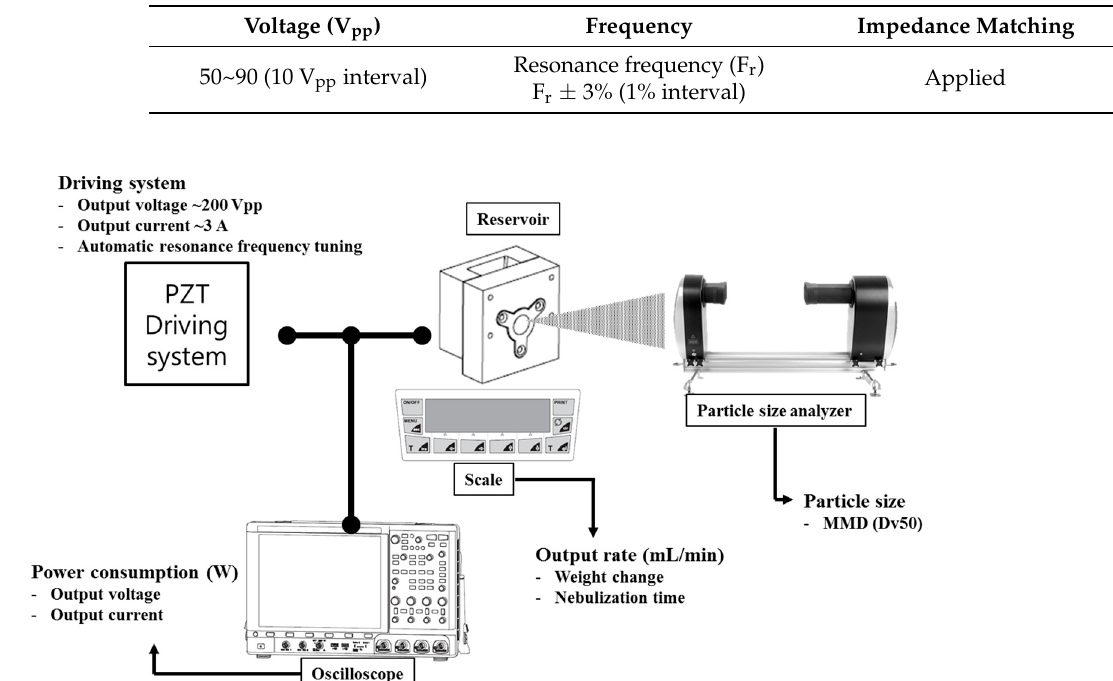
Figure 4. Experiment setting for measuring output rates, particle sizes, and power consumptions.